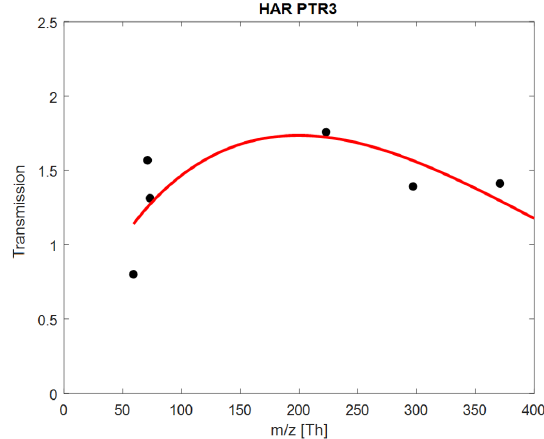
Figure A2. Retrieved transmissions for the Harvard PTR3, using a reduced subset of compounds: acetone; MVK; MEK; and D3, D4, and D5